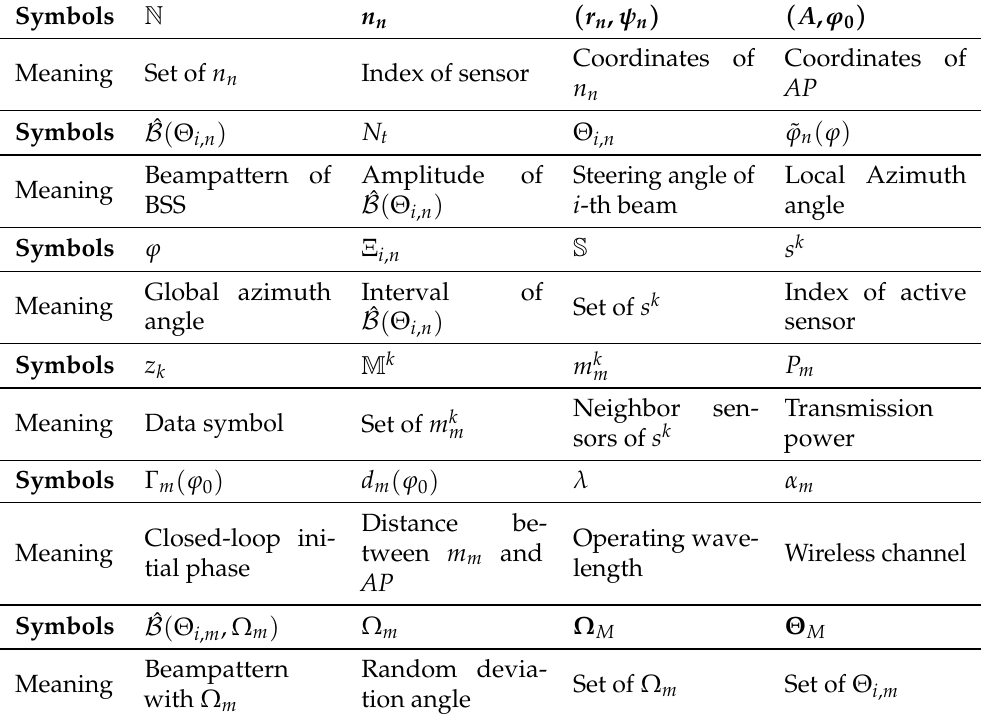
Table 1. Summary of the symbols in the system